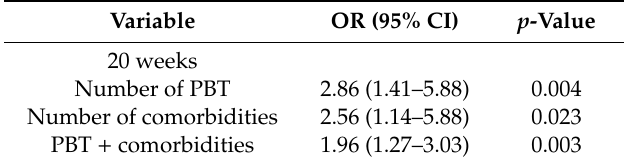
Table 2. Univariate logistic regression analysis of variables associated with PASI 75